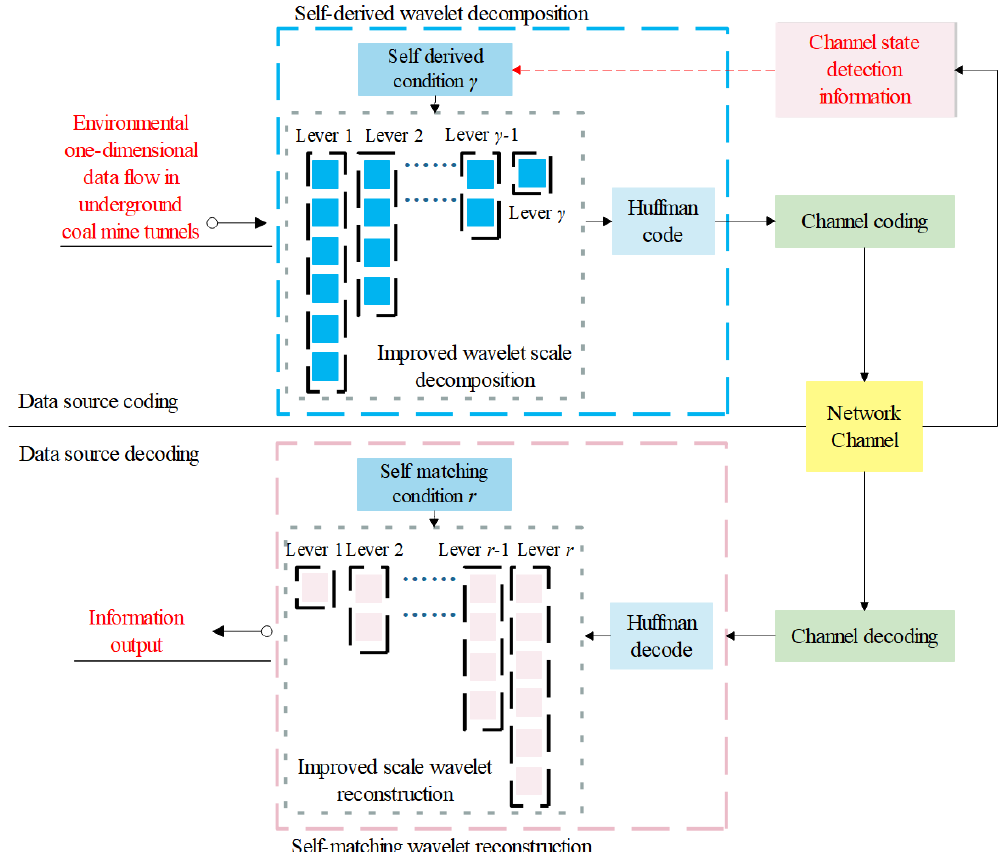
Figure 1. Structure and reconstruction algorithm for self-derived wavelet compression coding in underground coal mine tunnels.